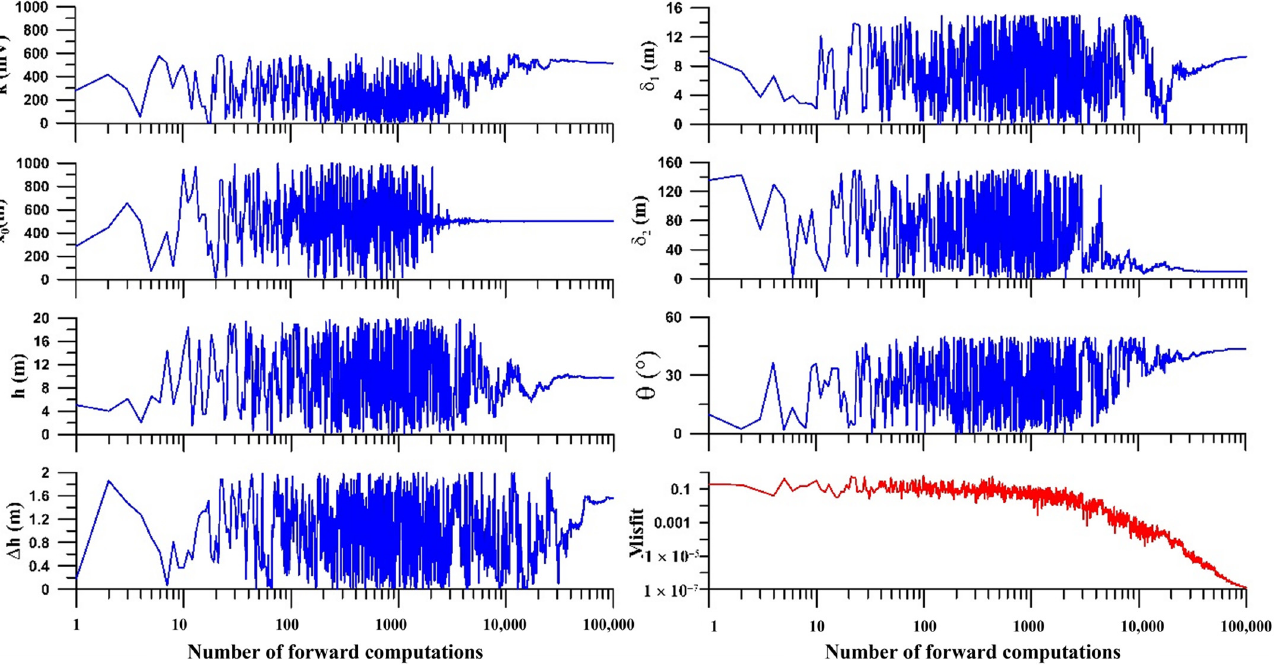
Figure 3. Convergence for all parameters and the misfit.